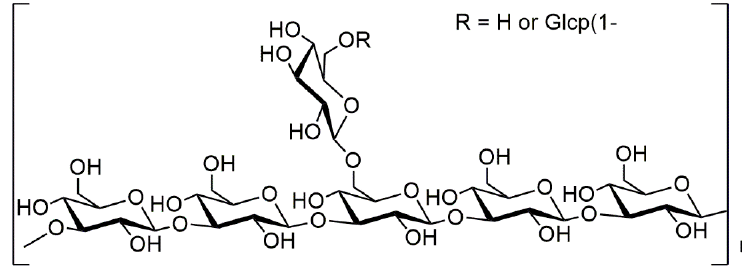
Figure 1. Representative chemical structure of botryosphaeran.